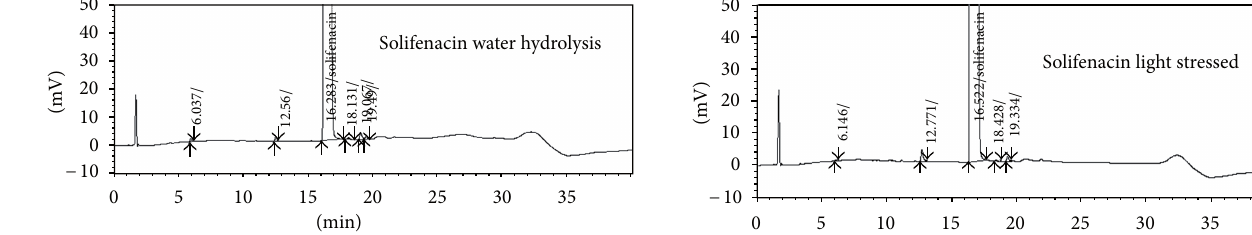
F 11: Typical HPLC chromatogram of UV stressed